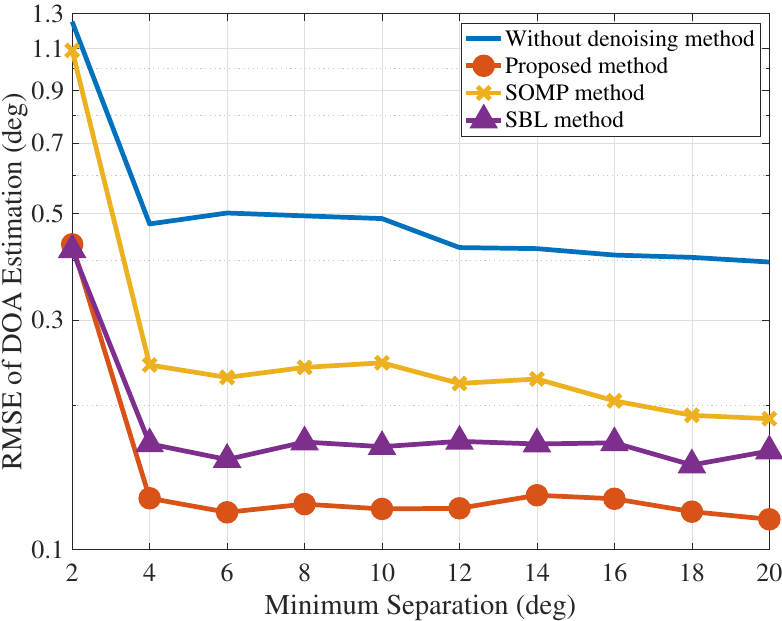
Figure 5. The DOA estimation with different DOA